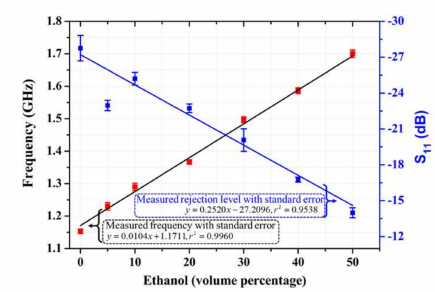
Figure 4. Measurement results of the sensor in terms of the change in frequency and reflection coefficient with respect to the volume percentage of